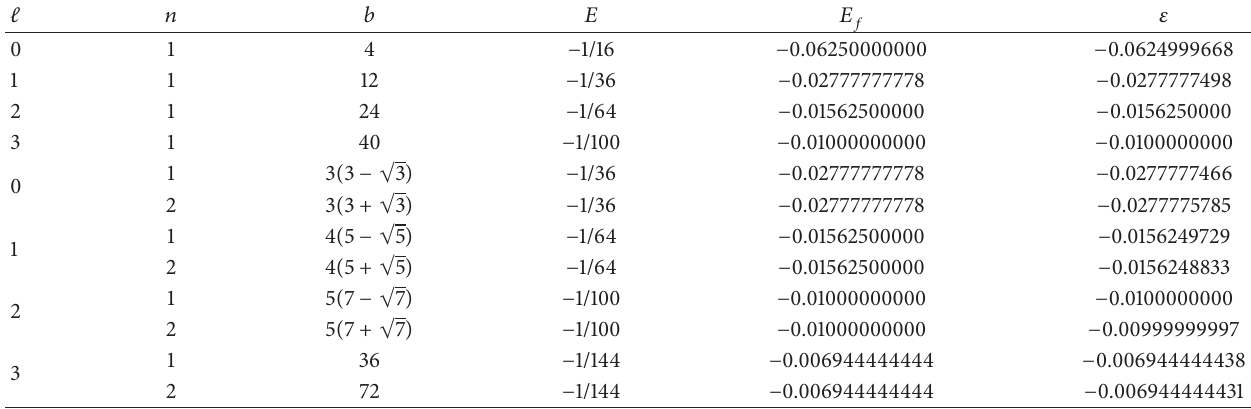
Table 8: Approximation of the energy levels of a confined hydrogenic atom in dimension 𝑑 = 3 . The angular-momentum quantum number is ℓ , 𝑛 is 1 plus the number of nodes of the radial wave function, 𝑏 is the radius of the box, 𝐸 is the exact value of the energy, 𝐸 in floating point arithmetic, and 𝜀 is the variational approximation obtained from the matrix H of dimension 𝑁 = 250 .